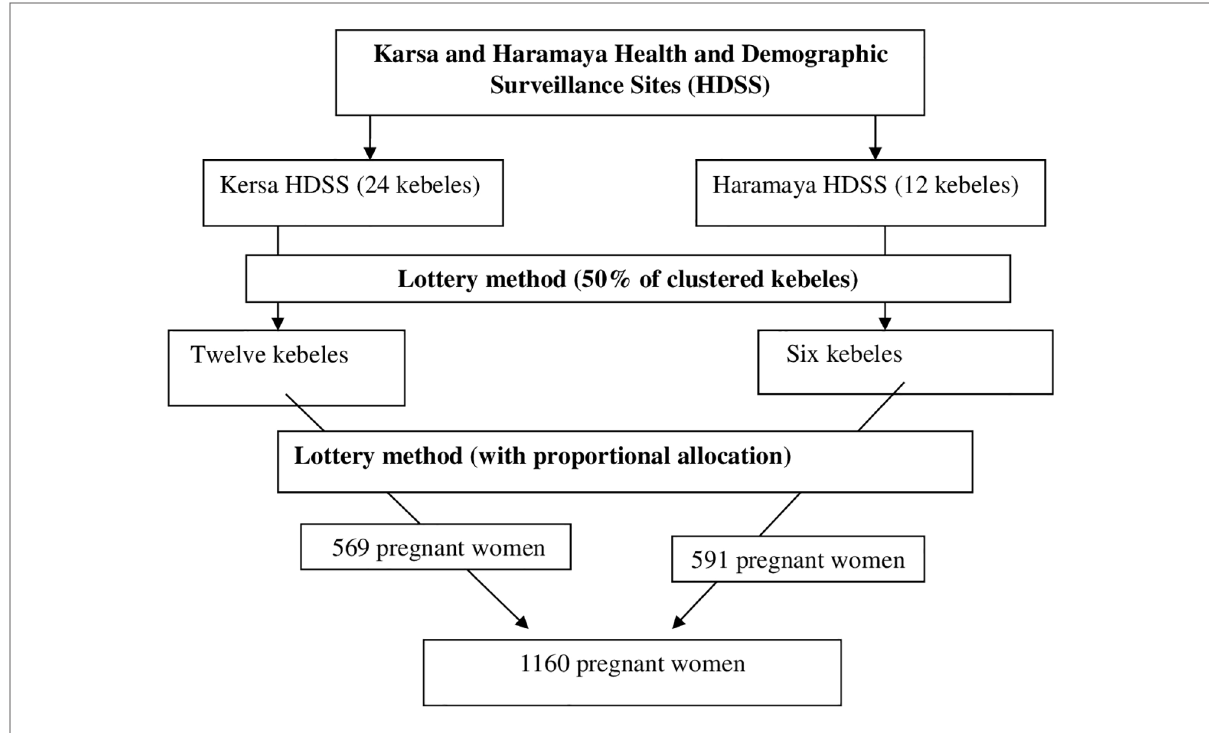
FIGURE 1 Schematic presentation of the sampling procedure for assessing khat use and associated factors among pregnant